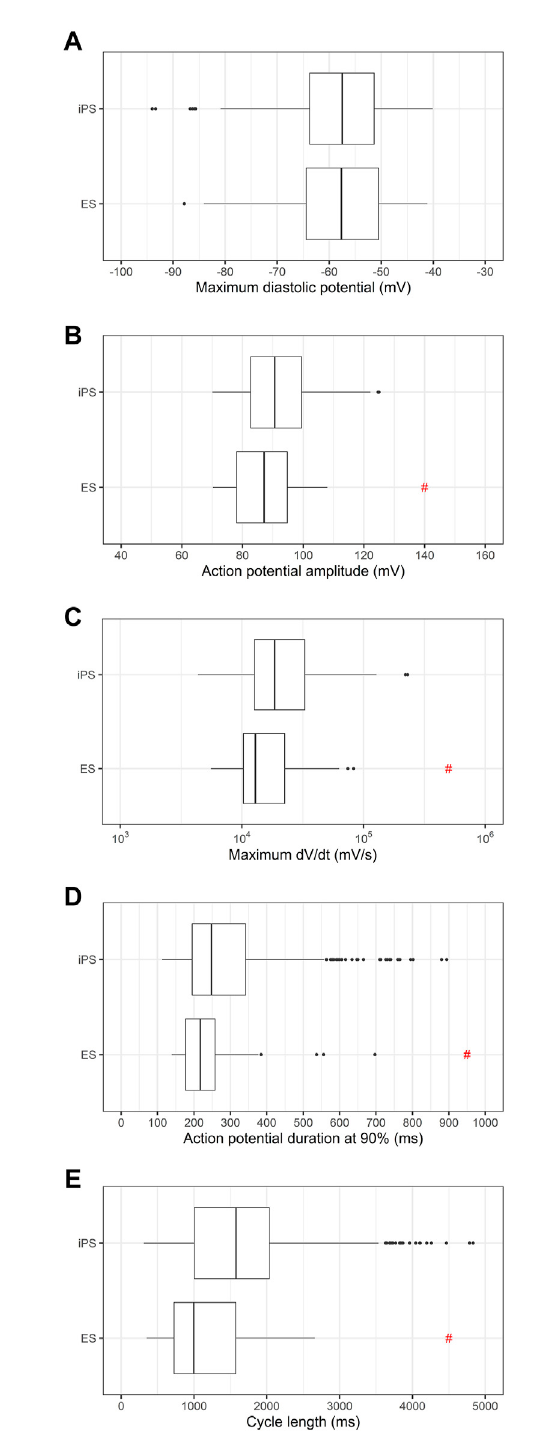
FIGURE 2 Comparison of electrophysiologic parameters between ES and iPS-derived cardiomyocytes. (A) Maximum diastolic potentials (MDP), (B) actionpotentialamplitudes(APA), (C) maximumdV/dt(dV/dtmax), (D) action potential duration at 90% repolarization (APD90) and (E) cycle length are shown. It is important to note that differentiation protocols varied between the two cell types, and herefore the signi fi cance of the differences may be attributable to the varying protocolsusedfordifferentiation. #indicates p < 0.05using Student ’ s t -test.